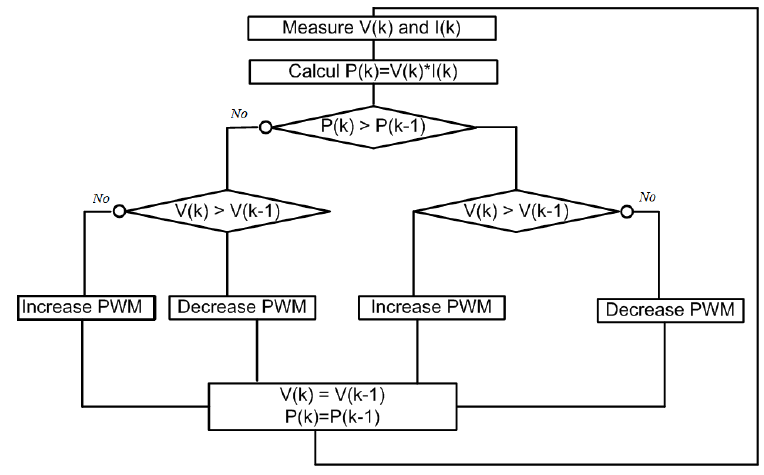
Figure 7. Flowchart of the P&O algorithm of the MPPT method.